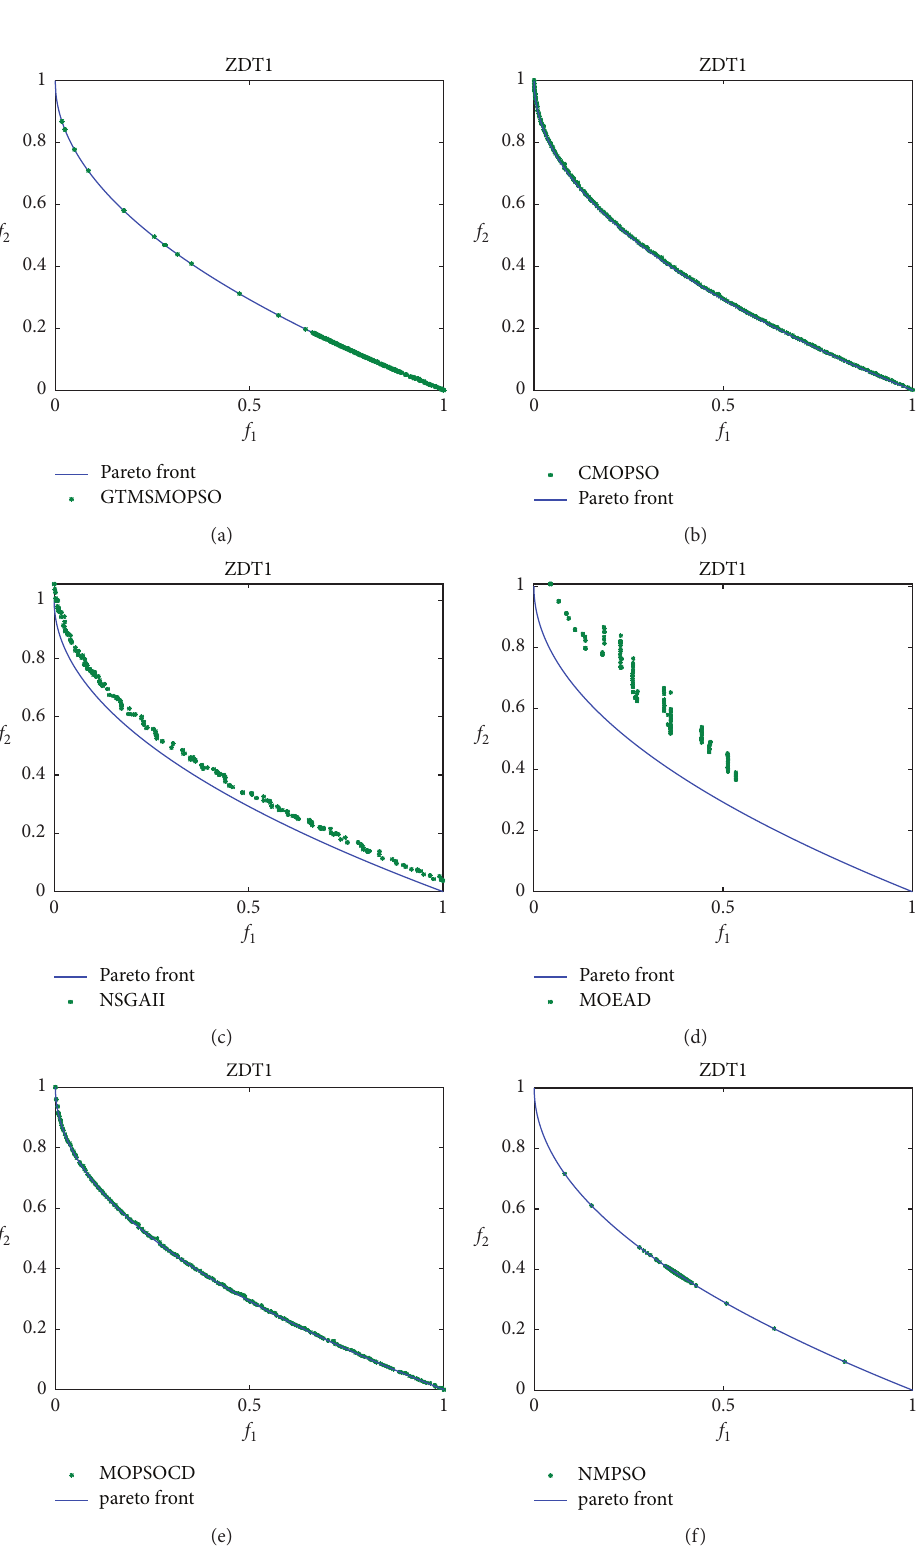
Figure 3: Pareto frontier effect of three different algorithms for ZDT1